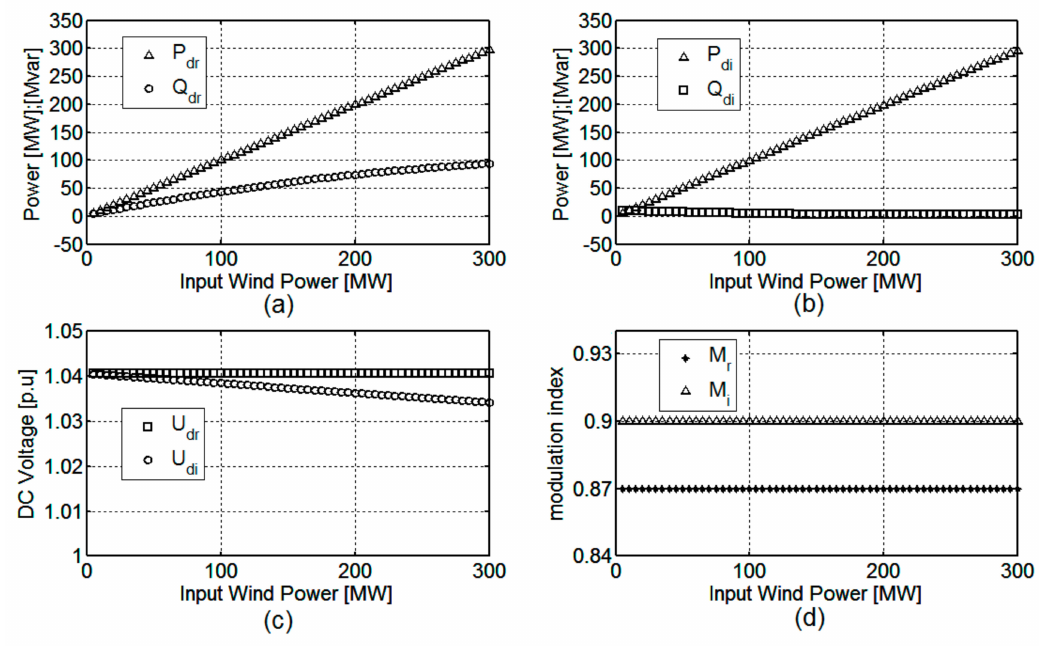
Figure 7. Steady-state curves without optimization (DFIG pf = 0.9): ( a ) Active and reactive power at the rectifier side of the VSC-HVdc model; ( b ) active and reactive at the inverter side of the VSC-HVdc model; ( c ) DC voltage in the VSC-HVdc model; ( d ) modulation indexes in the VSC-HVdc model. Now, a new non-optimal operation case is considered, where the DFIGs work with a unity power factor, as shown in Figure 8a.